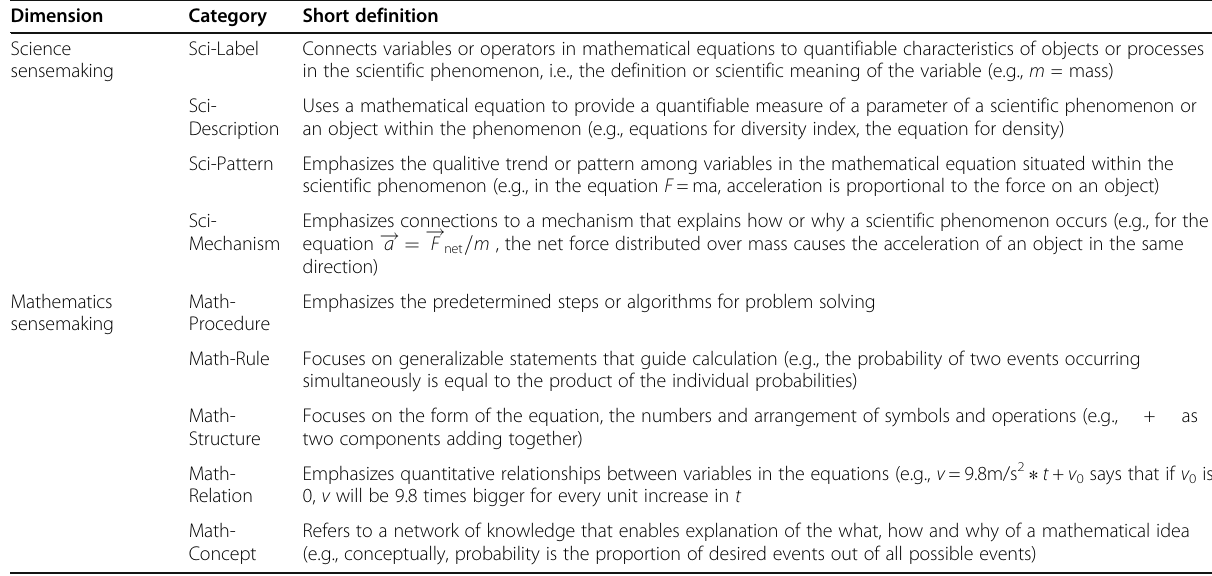
Table 1 Categories in the Sci-Math Sensemaking Framework (Zhao & Schuchardt, 2021)